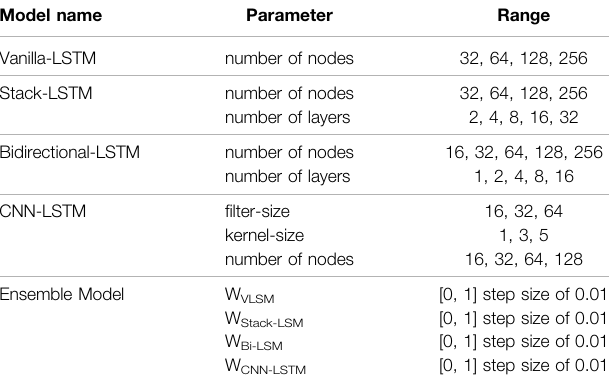
TABLE 2 | Parameters of the machine learning model and their